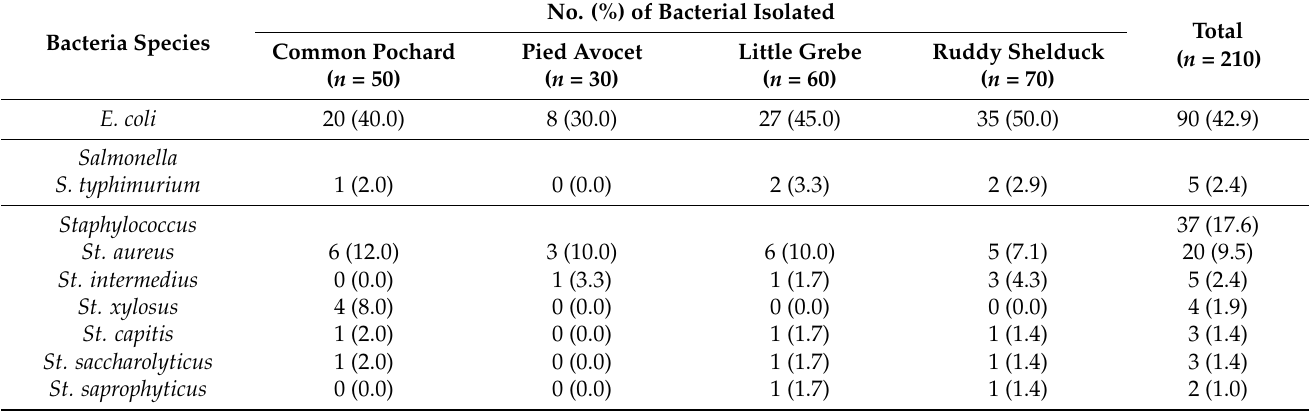
Table 1. Number and percentage of Escherichia coli , Salmonella typhimurium , and Staphylococcus spp. isolates recovered from different species of migratory wild birds around Al-Asfar